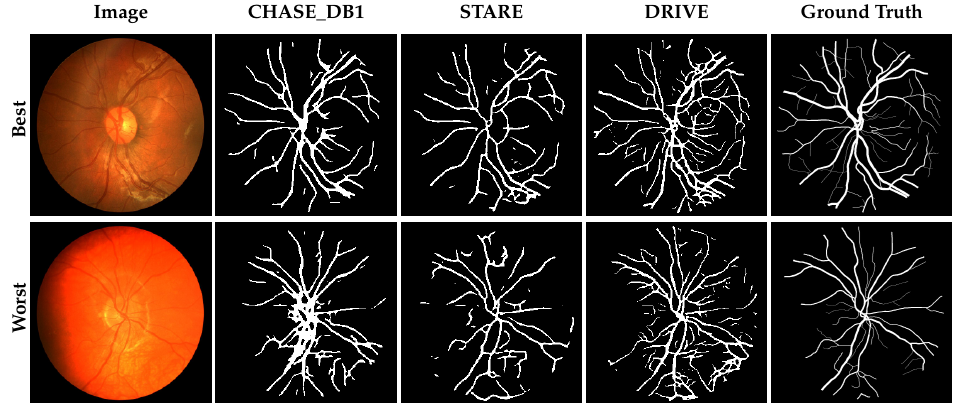
Figure 3. Network predictions on the STARE dataset. The top row shows the image, segmentation masks and ground truth for the image that scored best when STARE was used to train and test the model; the bottom row shows the worst. For comparison, the cross-validation results from training the model with DRIVE and CHASE_DB1 are shown.